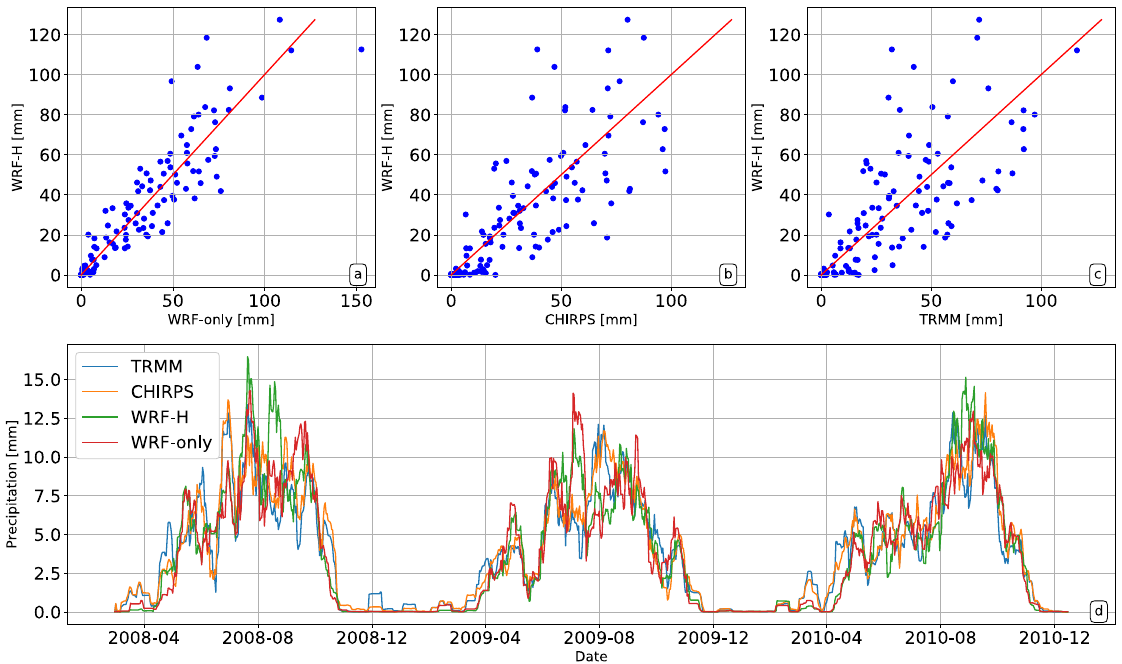
Figure 5. Evaluation of weekly simulated precipitations with observed datasets at the Savè catchment: ( a ) WRF-H vs. WRF-only, ( b ) WRF-H vs. CHIRPS, ( c ) WRF-H vs. TRMM, and ( d ) analysis of seven-day filtered daily precipitation for WRF-H, WRF-only, CHIRPS, and TRMM.